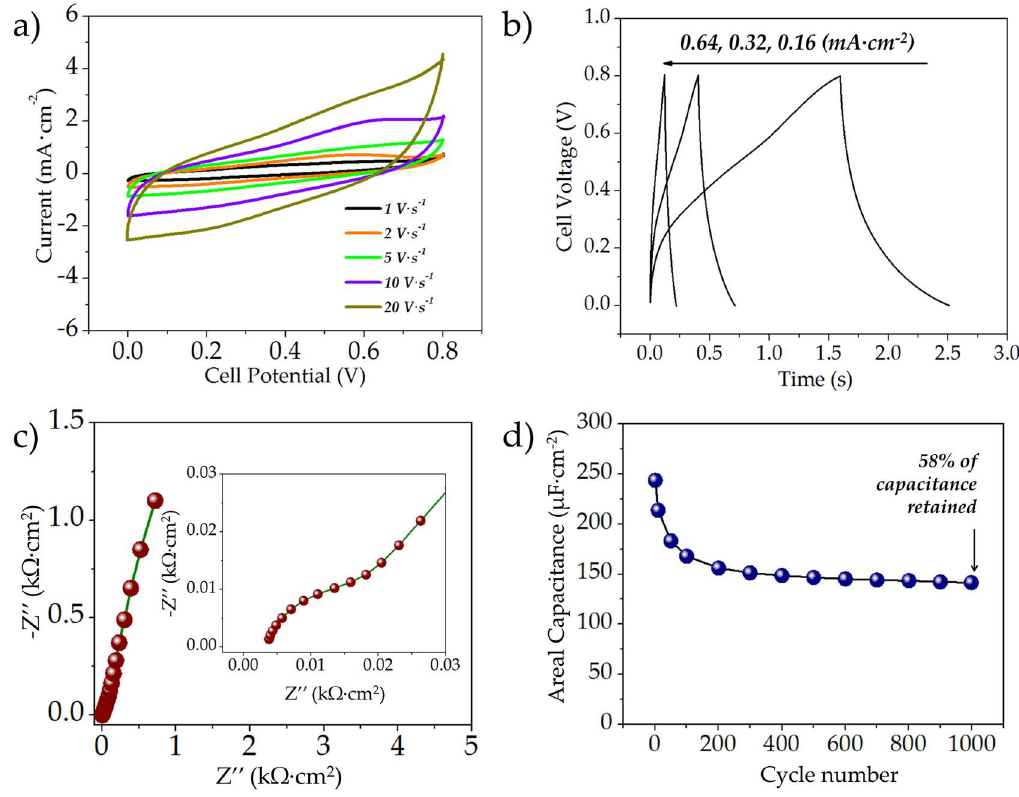
Figure 5. ( a ) Typical CV curves (scanned at 1–20 V · s − 1 ); ( b ) GCD curves at different current densities; ( c ) EIS spectra (between 100,000–0.01 Hz) and ( d ) cycle life of the symmetric MnO x //MnO x microsupercapacitor.